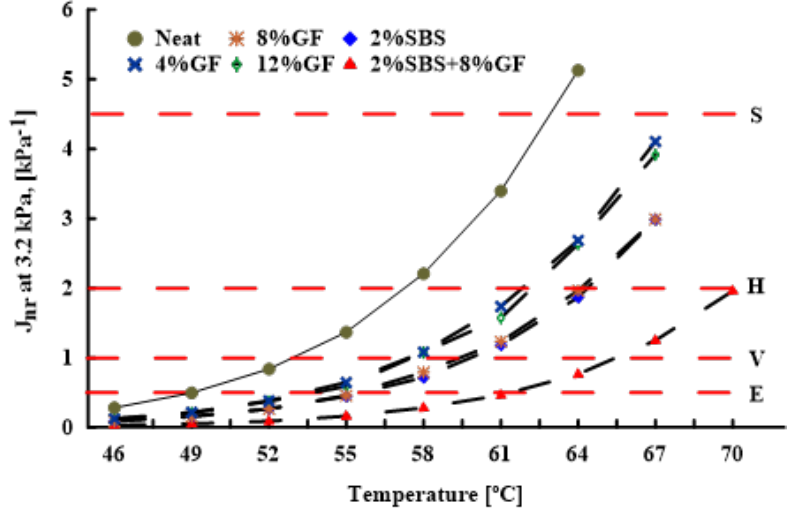
Figure 11. Temperature and additives effects on the traffic